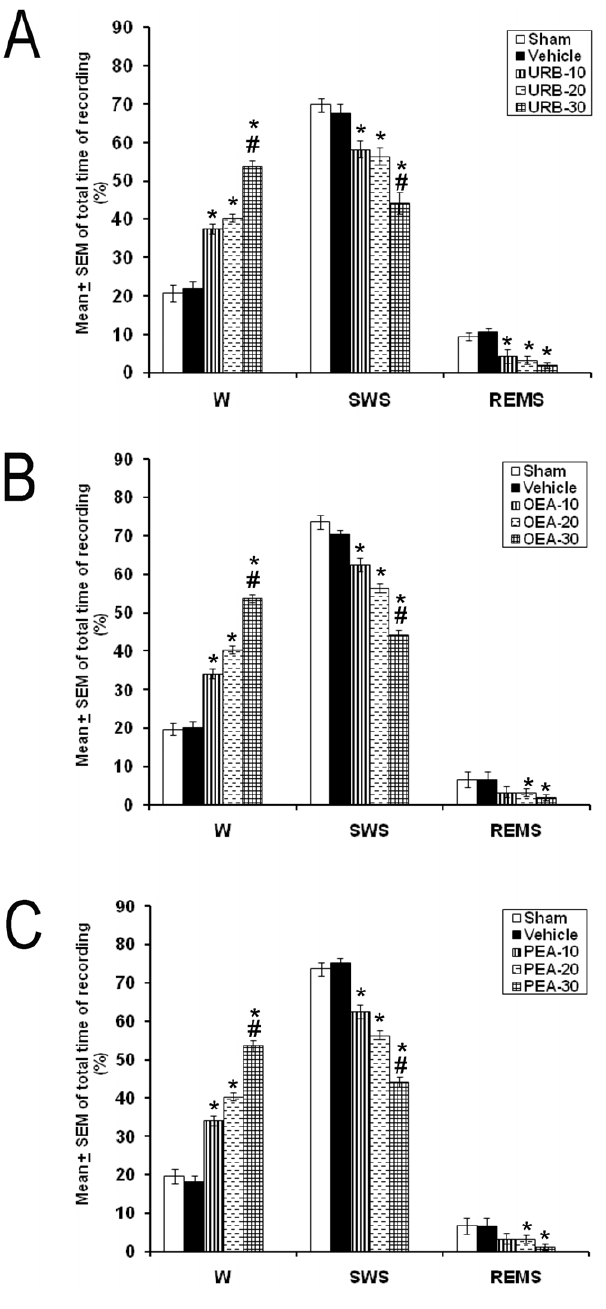
Figure 3. Effects on total time (3 h of sleep recordings) of W, SWS and REMS after administrations into the dorsal raphe nuclei of either URB597 (Panel A), OEA (Panel B) or PEA (Panel C). Pharmacological treatments (10, 20, 30 m g/1 m L; each compound) increased W and diminished SWS as well as REMS (Mean 6 SEM of total time of recording [%]; * vs. Sham/Vehicle, p , 0.05; # vs. respective compound at 10 or 20 m g/1 m L, p , 0.05; & vs. respective compound at 10 or 20 m g/1 m L, p , 0.05).